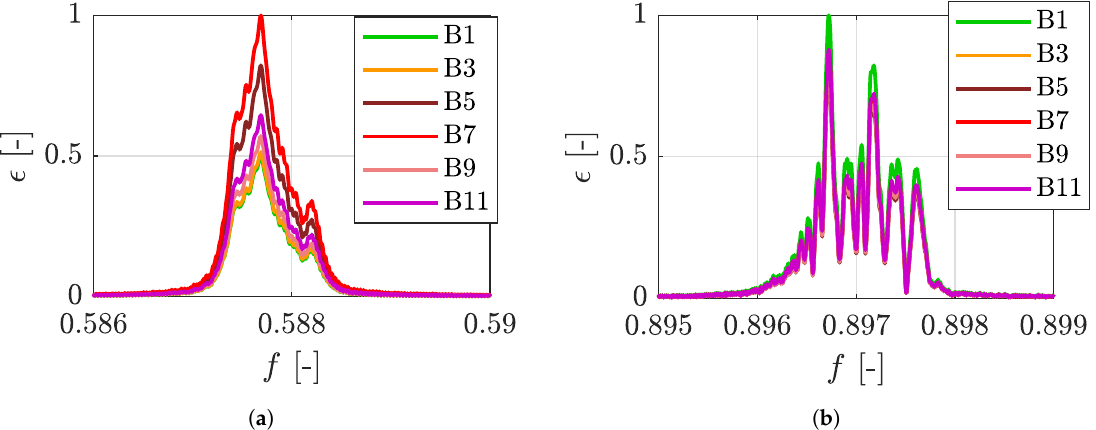
Figure 4. Vibratory Modes 6 and 9: Frequency domain. ( a ) Normalized amplitude of all SG-applied blades during resonance M6; ( b ) Normalized amplitude of all SG-applied blades during resonance